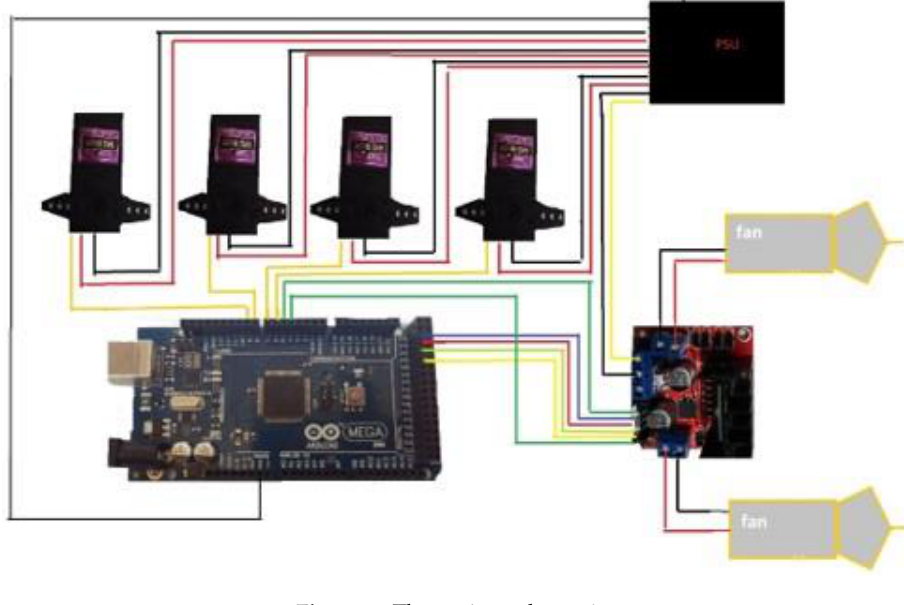
Figure 4. The project schematics.